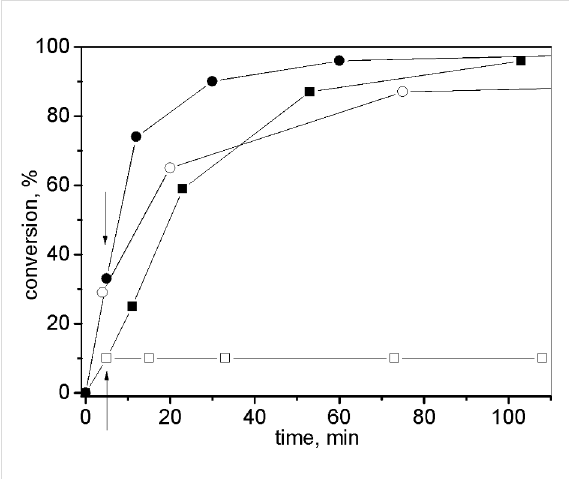
Figure 4: Filtration experiments with 3 /SBA-15. RCM of DEDAM in benzene (circles), 1,7-octadiene in cyclohexane (squares), liquid phase in contact with solid catalyst (filled symbols), liquid phase after filtration (open symbols), arrows indicate time of filtration. Substrate/Ru